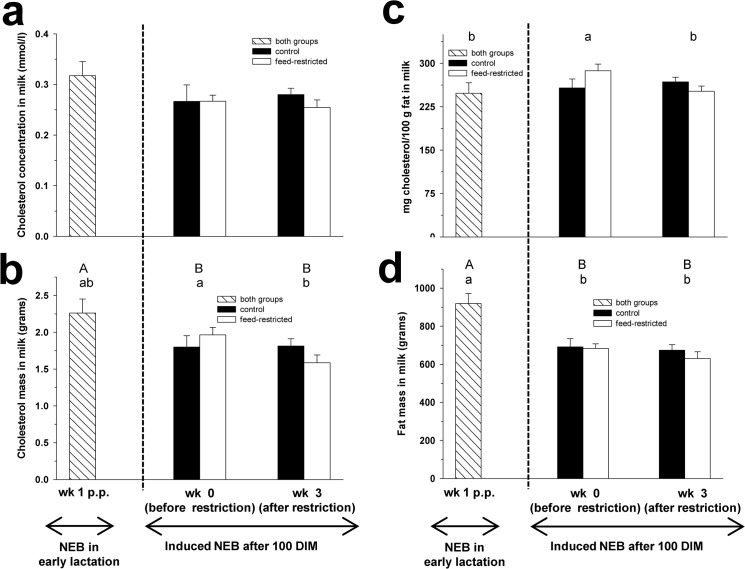
Milk cholesterol.Cholesterol concentration (mmol/l) in milk (Fig 5a), cholesterol mass (grams) in milk (Fig 5b), cholesterol concentration in milk fat (mg cholesterol per 100 g fat; Fig 5c) and fat mass (grams) in milk (Fig 5d) in week 1 p.p., and before (week 0) and after (week 3) feed restriction in mid-lactation. Changes over time within the groups are marked with superscripts (A and B for the control group (CON); a and b for the feed-restricted group (RES); P < 0.05). Data are presented as means ± standard error of the mean.